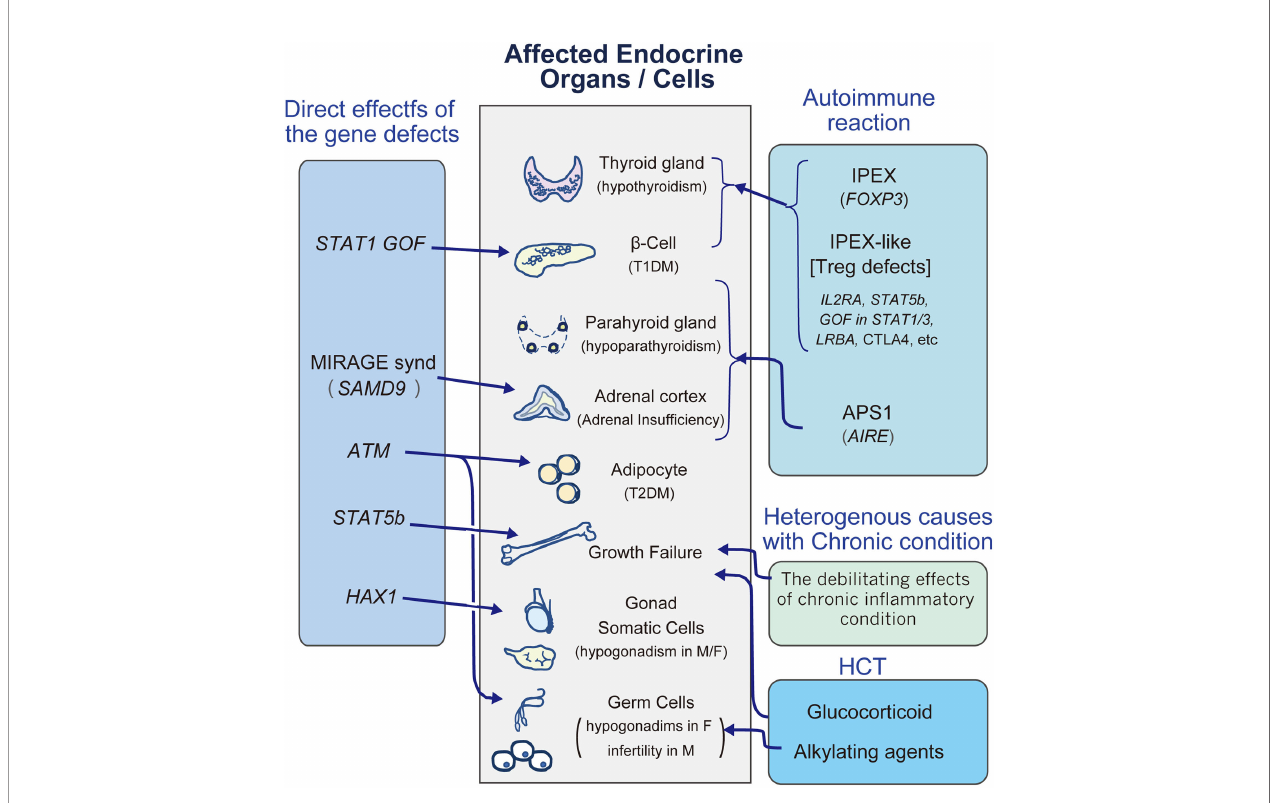
FIGURE 1 | A diagram to review the major endocrinopathies in IEI. M, male; F, female; HCT, hematopoietic stem cell transplantation; T1DM, type1 diabetes mellitus; T2DM, type2 diabetes